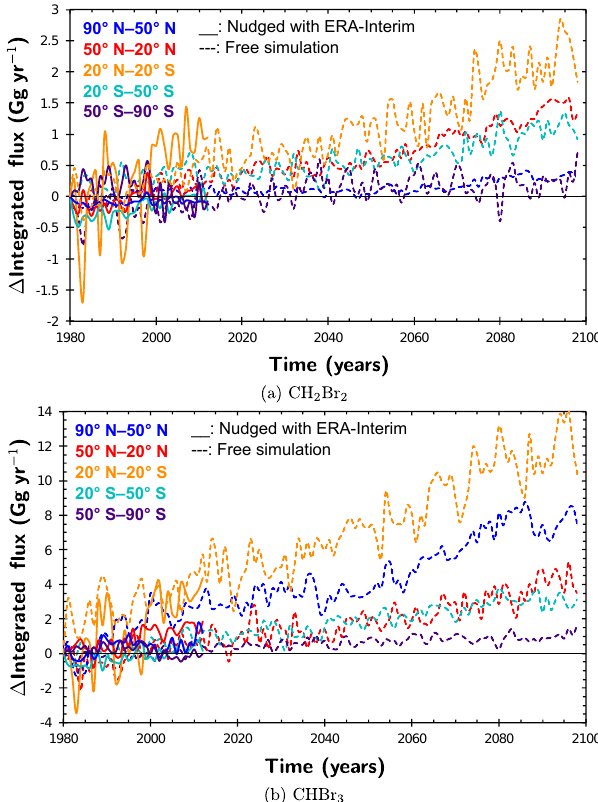
Figure 2. Difference of integrated flux separated in different zonal bands. Simplified chemistry EMAC simulation (SC_free and SC_nudged) with airsea gas exchange and water concentrations held constant. Solid lines represent ERA-Interim nudged (1979– 2012) and dashed lines free-running